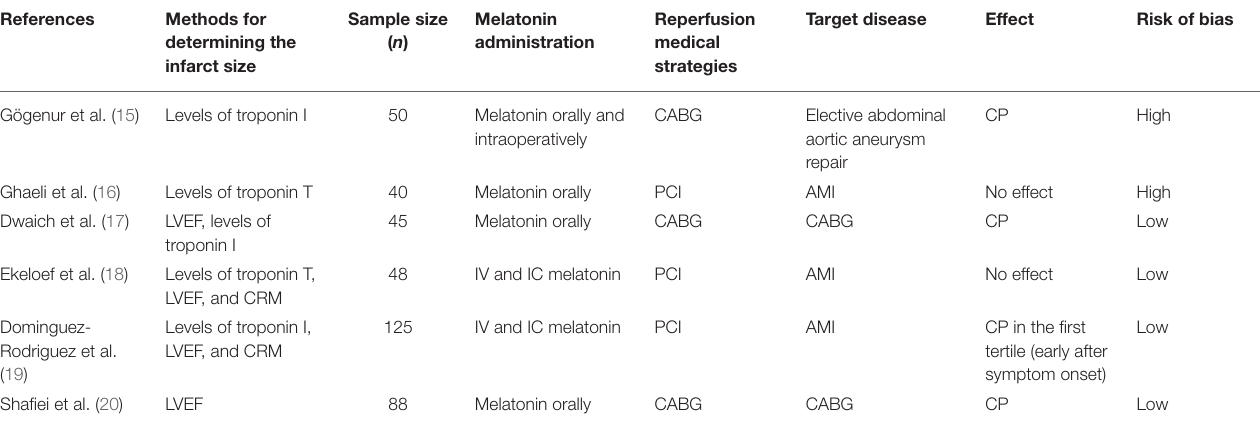
TABLE 1 | Overview of the studies included in the